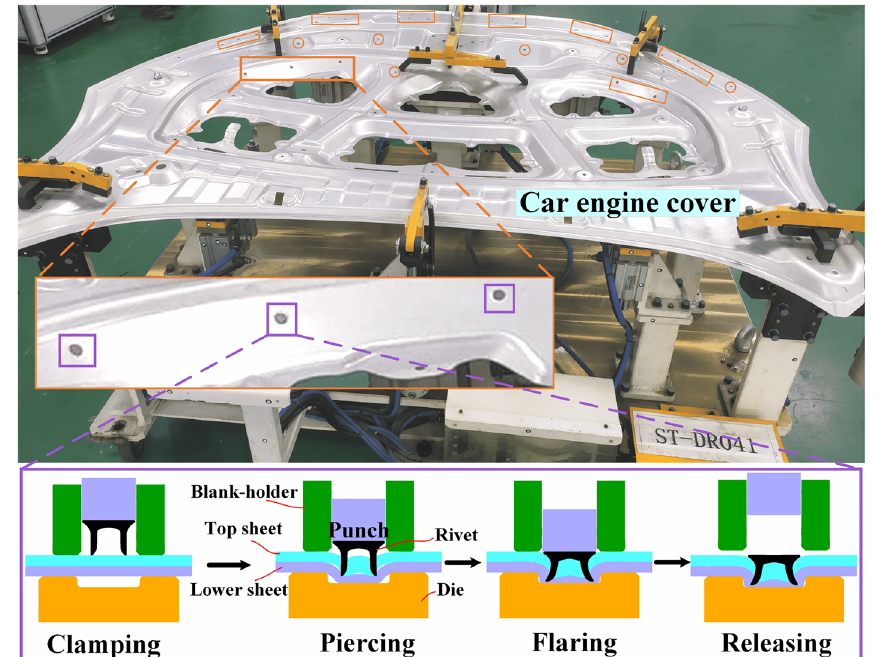
Figure 1. Body SPR forming and SPR technology.